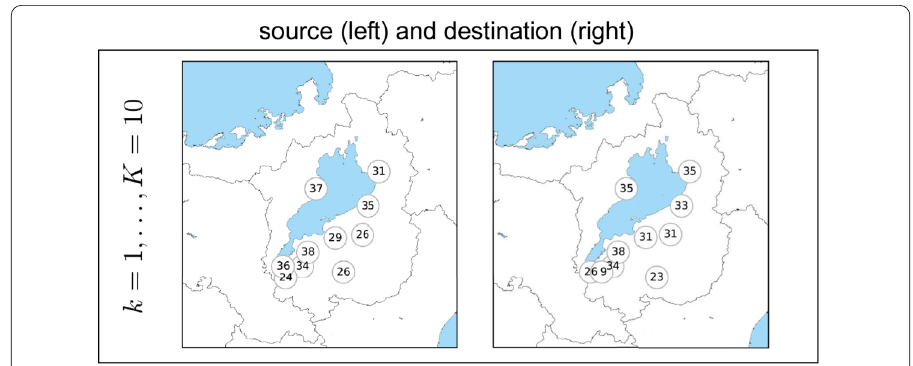
Figure C.1 Circular areas corresponding to the basis vectors and proportions of the vector entries included in the circular areas. The left figure is for w k , i.e., the basis vectors for sources, and the numbers are the levels of concentration, β max ( w k ), while the right figure is for h k , i.e., the basis vectors for destinations, and the numbers are β max ( h k ), for k = 1,2, ... , K =